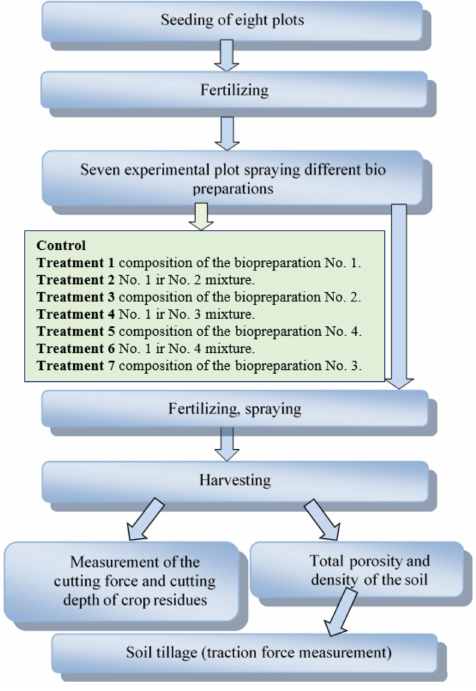
Figure 2. Technological operations and experimental research plan.